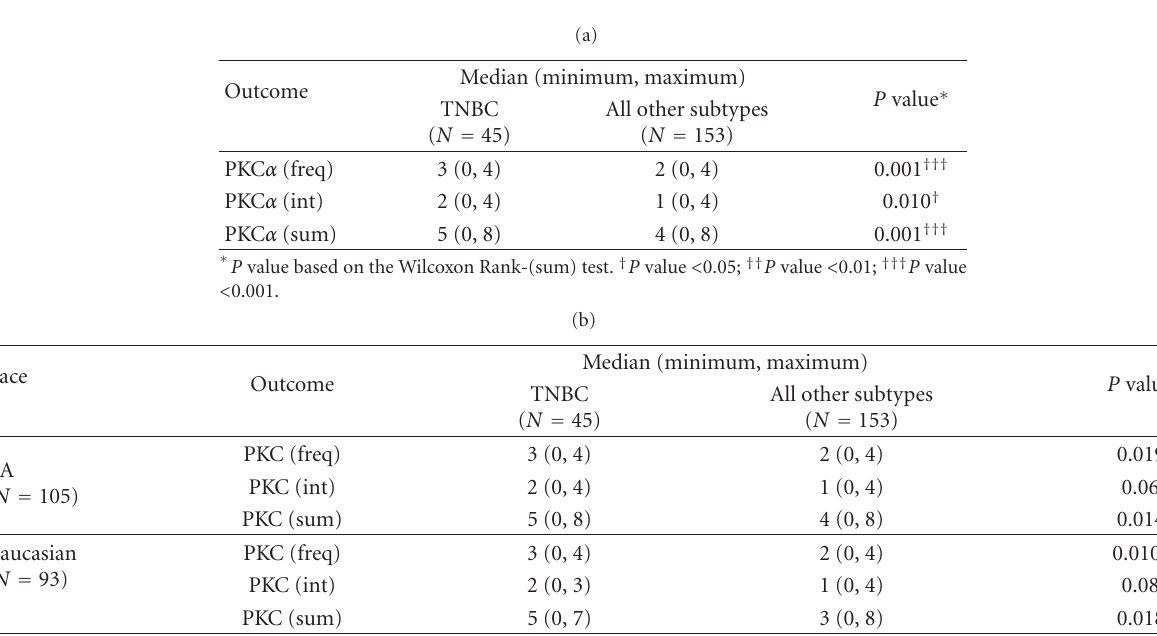
Table 4: (a) PKC α expression is higher in triple-negative breast cancers compared to other subtypes. (b) Correlation of PKC α expression and triple-negative breast cancer is similar in African American and Caucasian